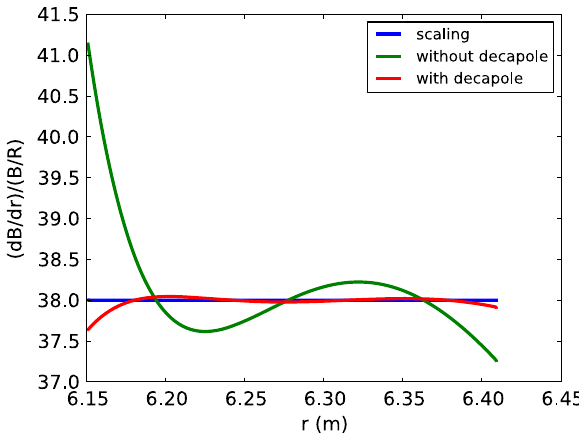
FIG. 19. The local k value with and without decapole field component.